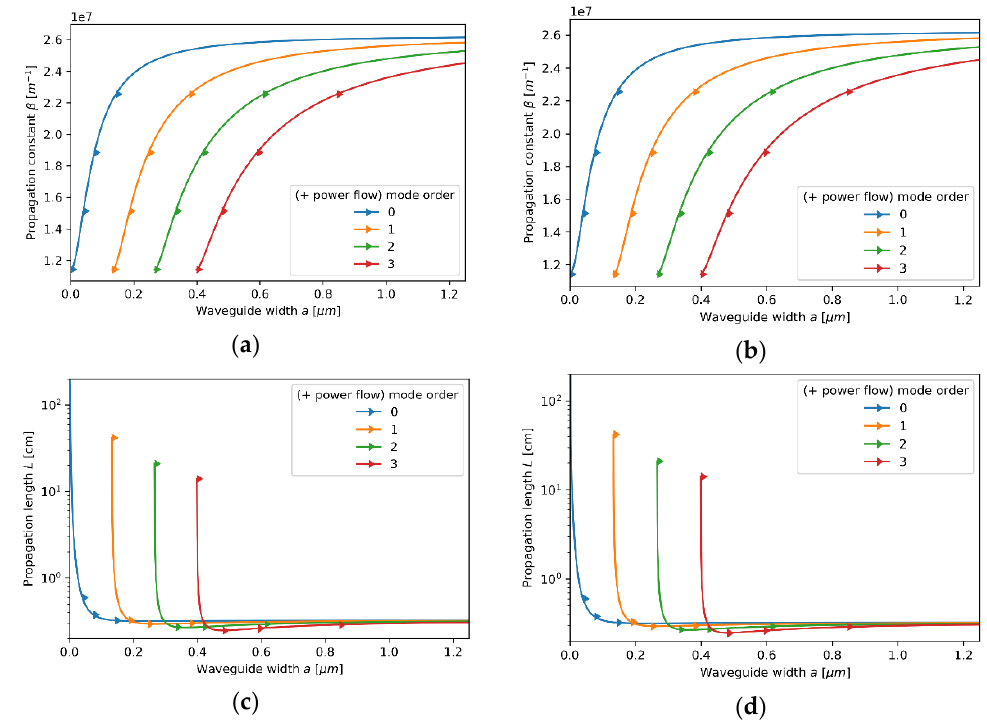
Figure 3. Propagation constant ( a , b ) and propagation length ( c , d ) of TE modes plotted versus waveguide width for an HMM waveguide with Nb2O5 layer of t Nb2O5 = 5 nm thickness embedded in the unit cell and described with local ( a , c ) and nonlocal EMT ( b , d ).